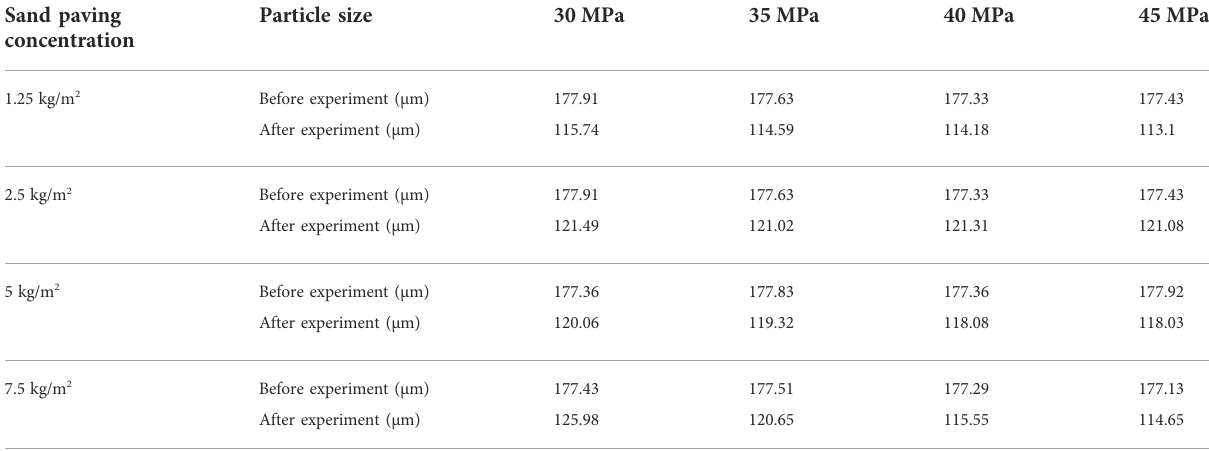
TABLE 4 Comparison of particle size changes before and after the conductivity experiment of proppant CF 70 – 140. Sand paving